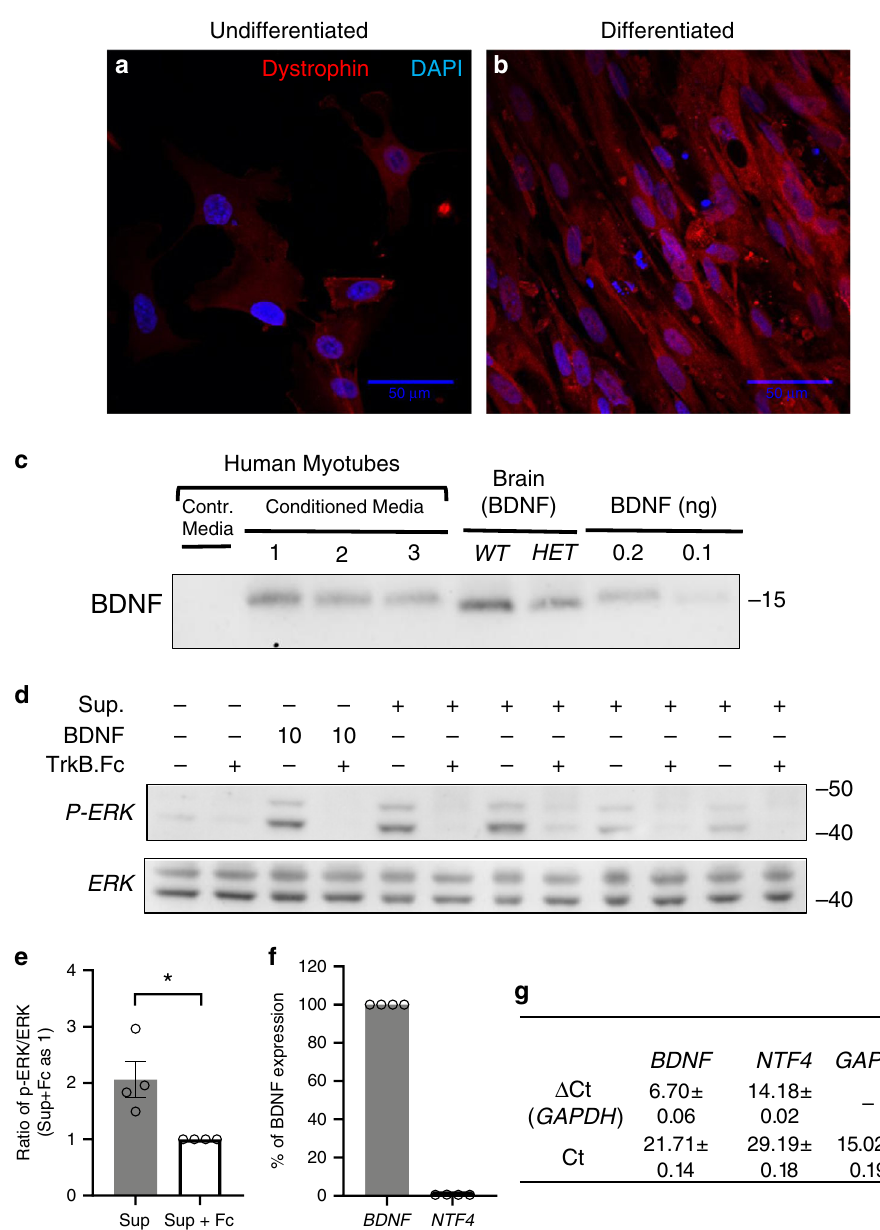
Fig. 10 Human primary skeletal muscle myoblasts secrete biologically active BDNF. a – g Adult, human primary skeletal muscle myoblasts ( a ) differentiated in vitro for 5 days express dystrophin ( b ). c – e Differentiated human myotubes secrete biologically active BDNF. c Western blot analysis of conditioned media from three independent cultures (1 – 3) immunoprecipitated with the TrkB-Fc protein and immunoblotted with an anti-BDNF antibody. Equal amounts of brain lysates from WT and Heterozygous (HET) mice were used as control. Recombinant BDNF was used to test sensitivity. d Conditioned media from differentiated human myotubes was tested for BDNF biological activity as in Fig. 6l and quanti fi ed from four